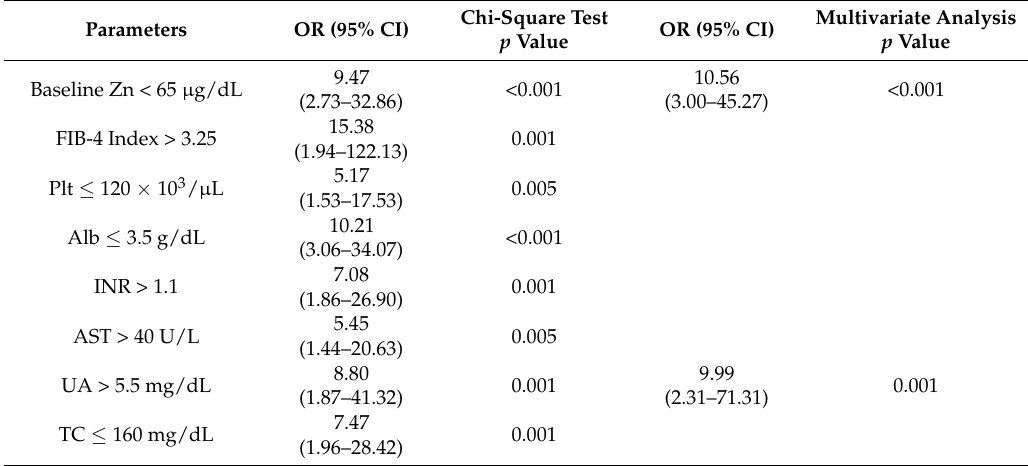
Table 2. Independent Risk Factors for Zinc Deficiency Two Years after Sustained Virologic Response (Zn-2y).